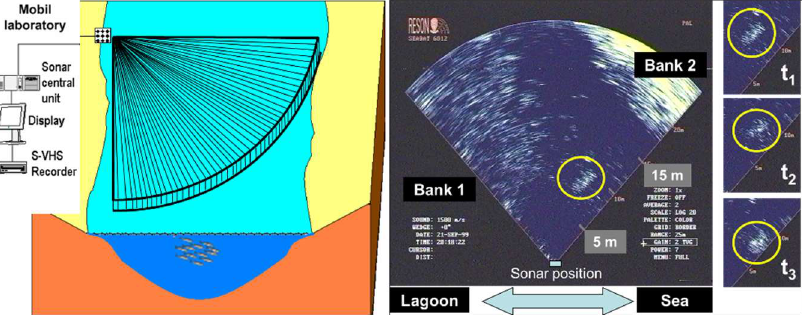
Figure A1. Scheme representing the sonar data collection, their treatment, which include several steps (selection of sonar sequence, digitalization, identification of echo traces on sonar images, data extraction and then exportation for final analysis on ad hoc software), and their analysis to obtain the swimming speed measurements.